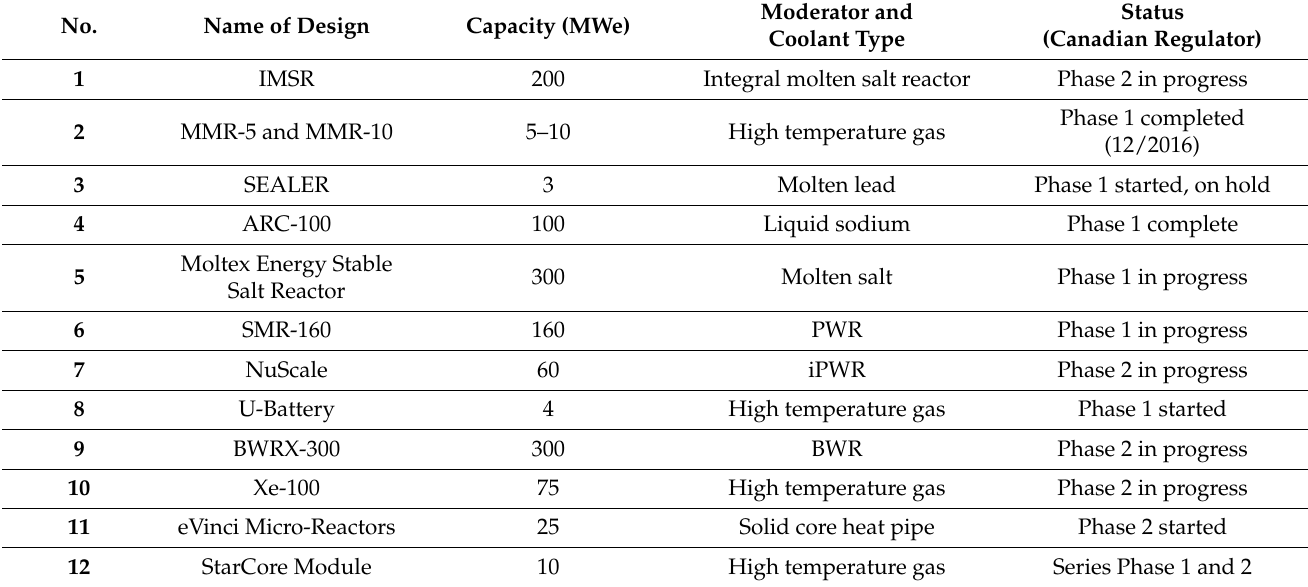
Table 1. VDR service agreements between the vendor and the CNSC. Adapted from [52] (as